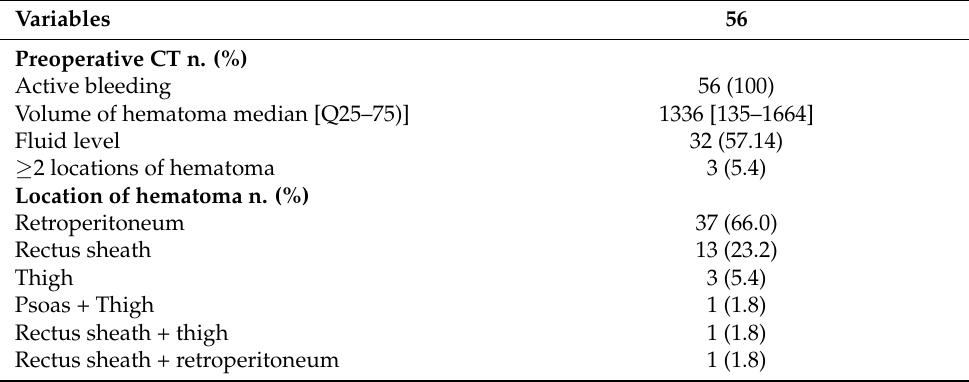
Table 3. Pre-procedure patient